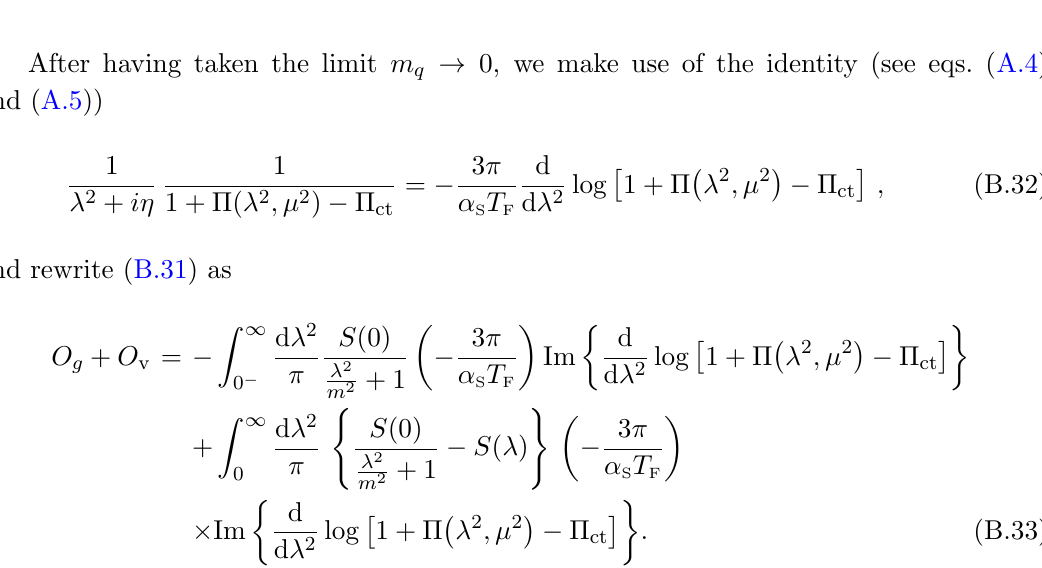
! 0, we make use of the identity (see eqs. (A.4) q